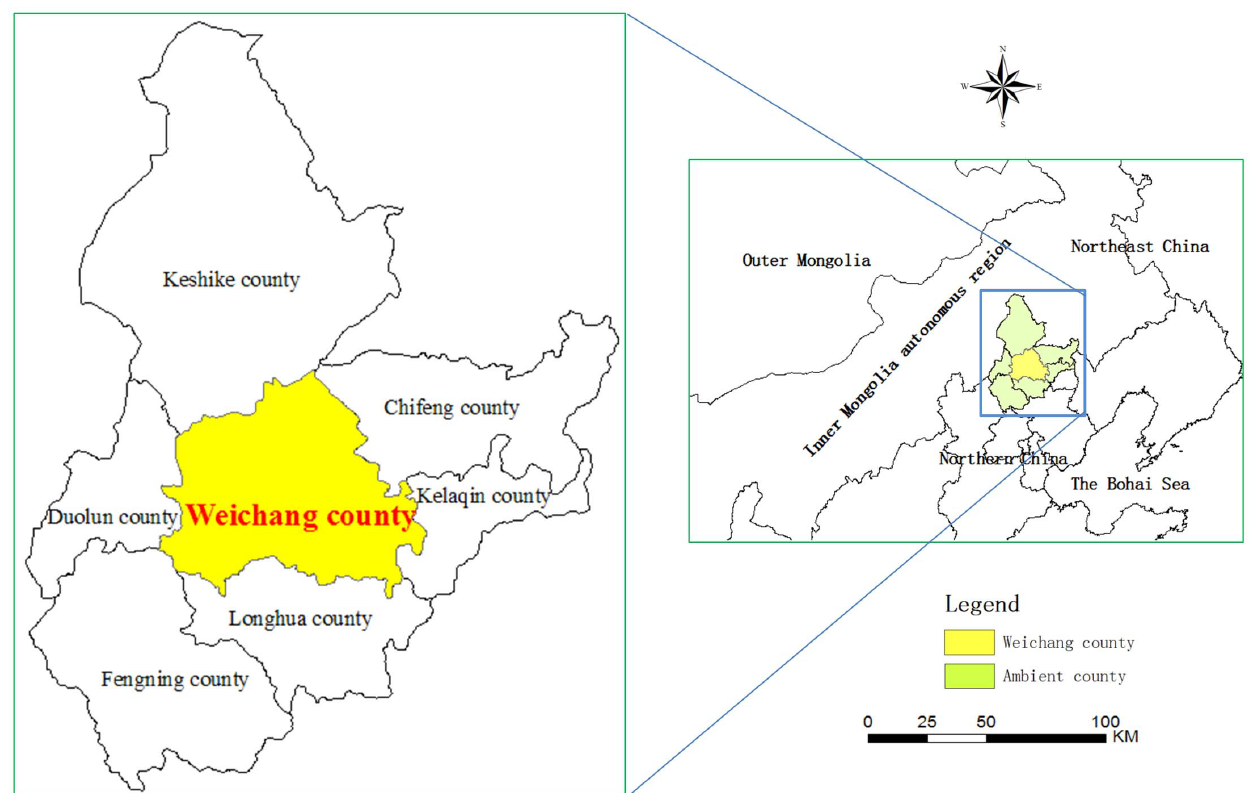
Figure 4. Location of the study area: Weichang County, Hebei Province, China.